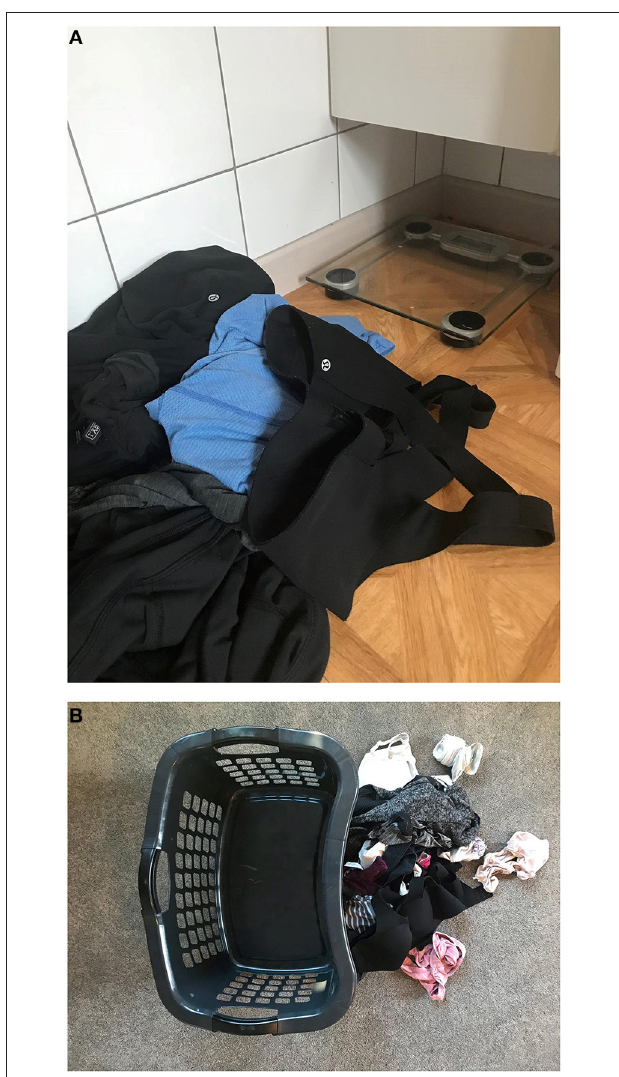
FIGURE 1 | (A,B) Images of activewear in laundry piles collected during our “living with the sports bra” experiment.